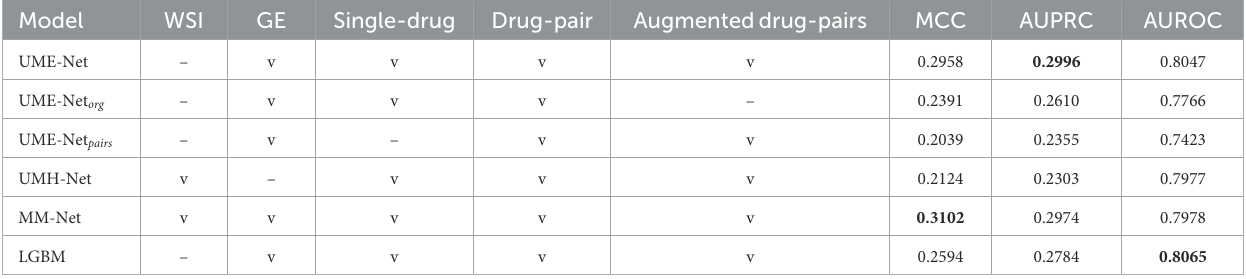
TABLE 2 Performance metrics including MCC, AUPRC, and AUROC are listed for drug response prediction models (UME-Net, UME-Net org , UME-Net pairs , UMH-Net, MM-Net, and LGBM). Model WSI GE Single-drug Drug-pair Augmented drug-pairs MCC AUPRC